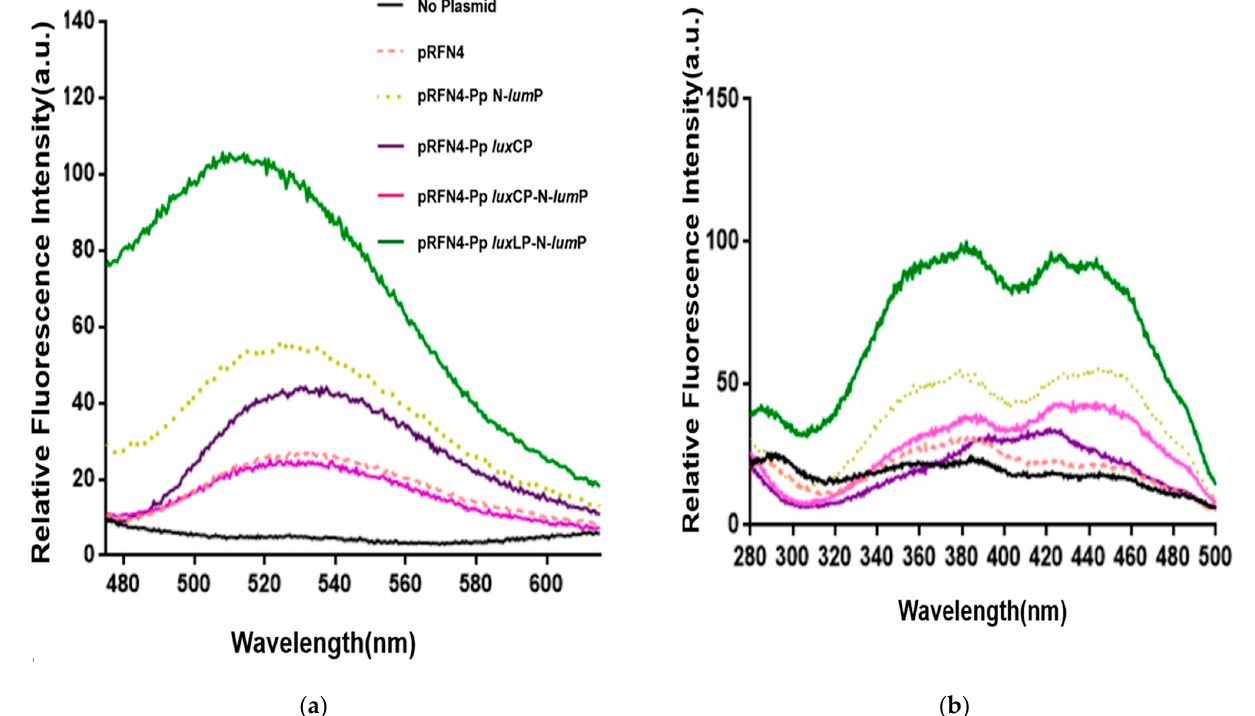
Figure 8. Fluorescence spectra of E. coli 43R transformed with recombinant pRFN4 plasmids con- taining P. phosphoreum lux DNA. ( a ) Emission spectra in fixation at excitation wavelength of 450 nm. ( b ) Excitation spectra for emission at 530 nm.